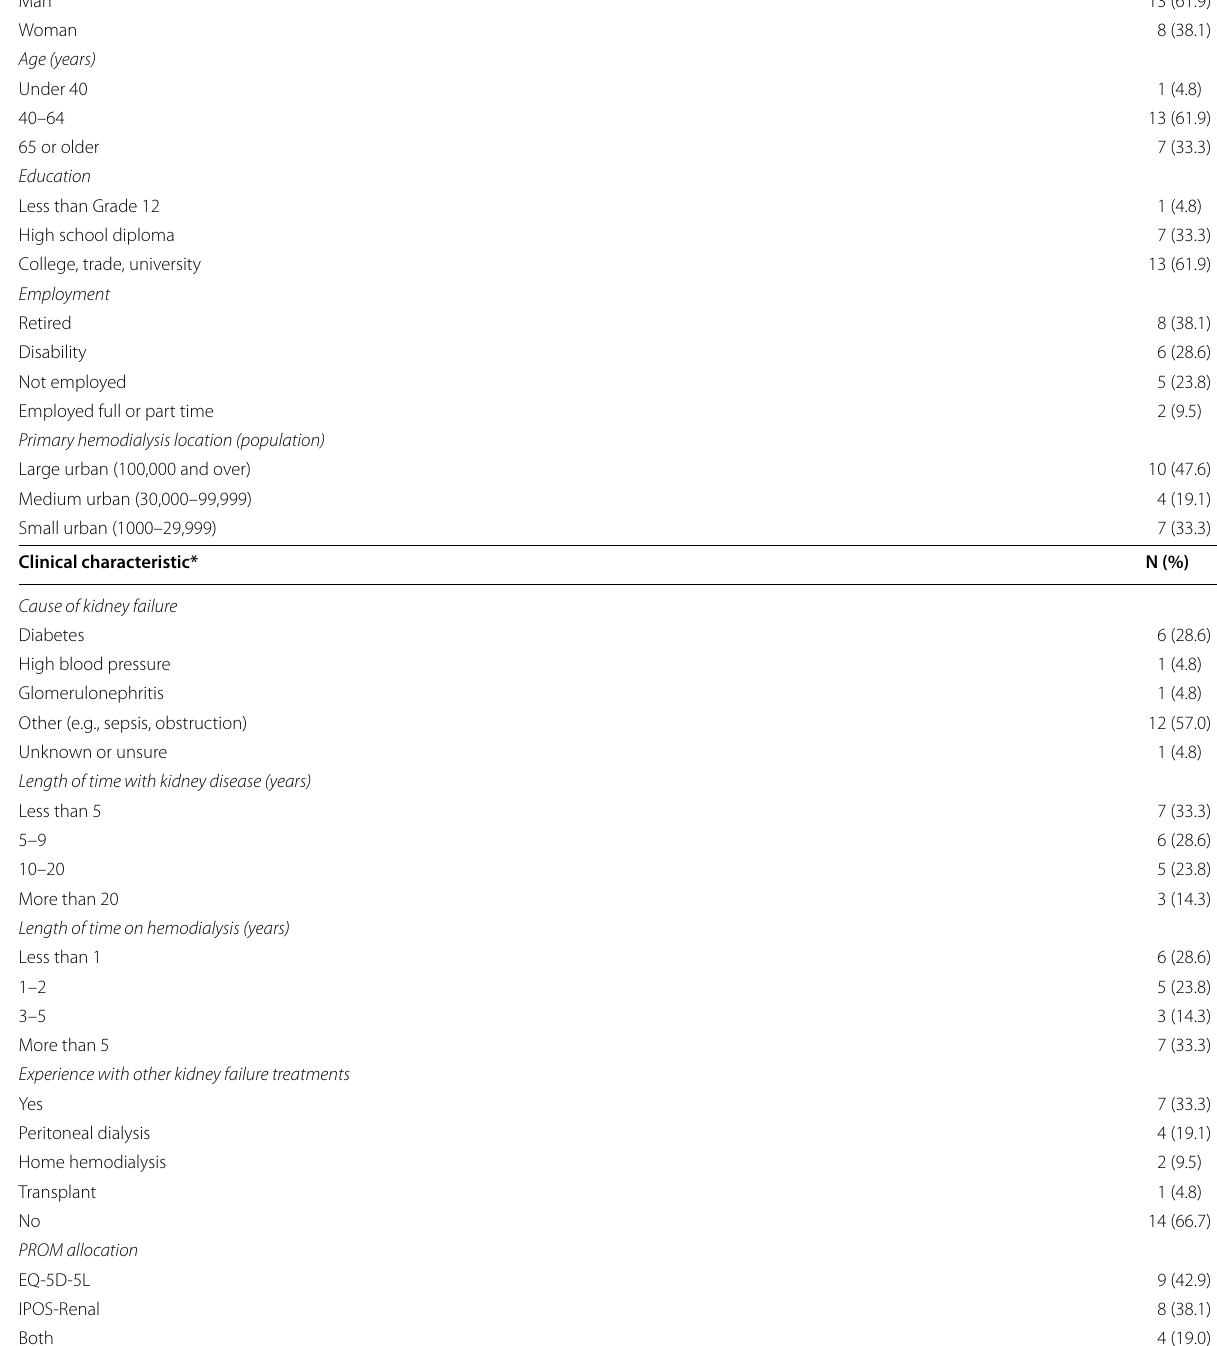
Table 1 Patient and caregiver characteristics (n